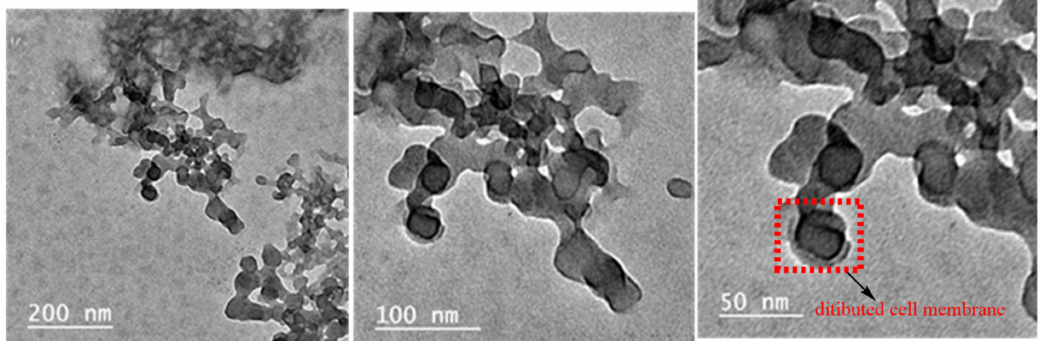
Figure 6. TEM micrographs of methicillin-resistant Staphylococcus aureus ( MRSA ) treated with 11a showing incomplete cell wall destruction, cell